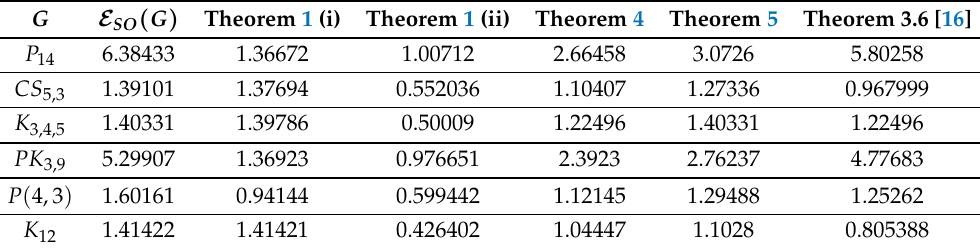
Table 3. Modified Sombor energy and the approximate values of the lower bounds obtained in the present paper and Theorem 3.6 of